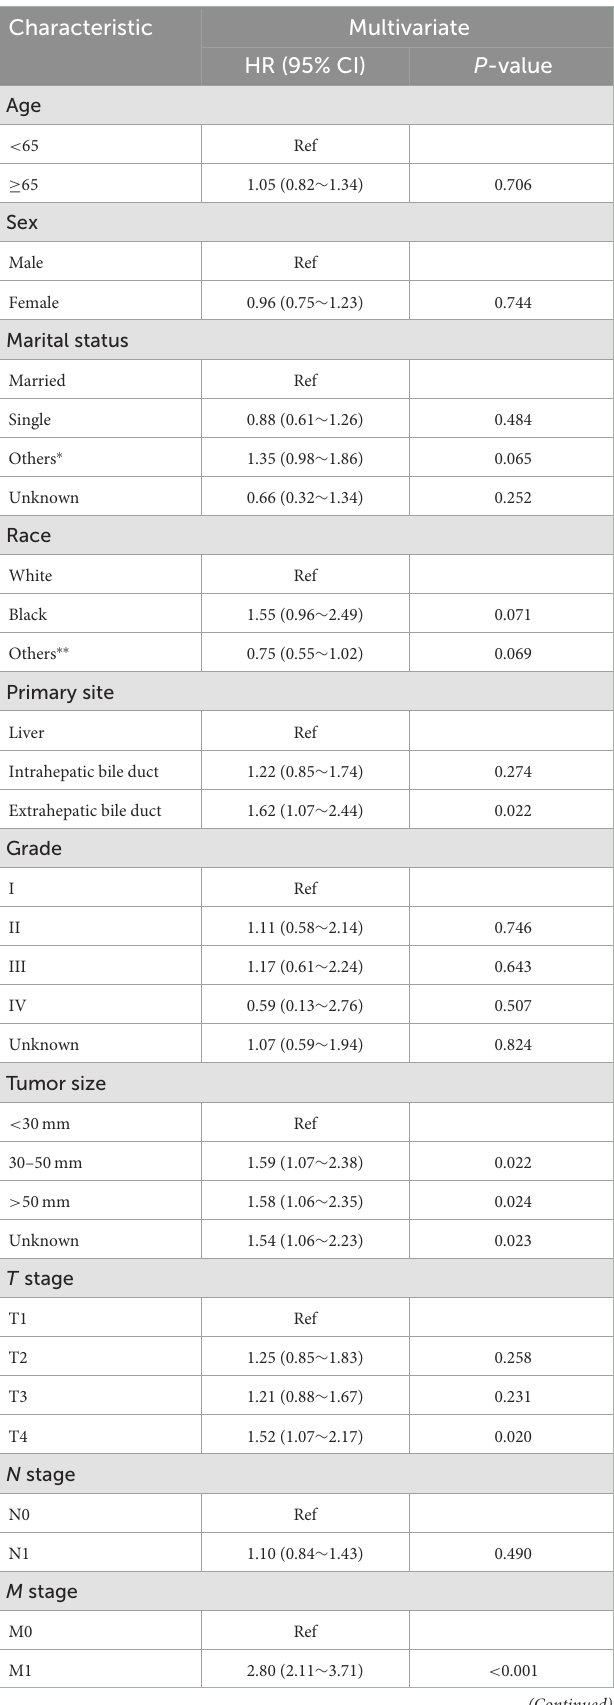
TABLE 2 Multivariate analyses for CSS in patients with